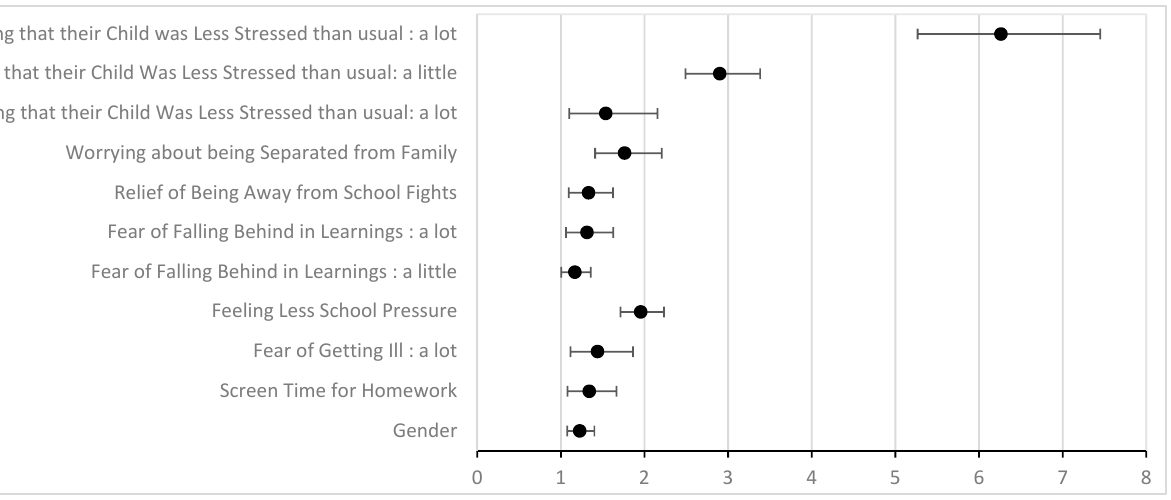
Figure 3. Risk factors significantly associated with S-.